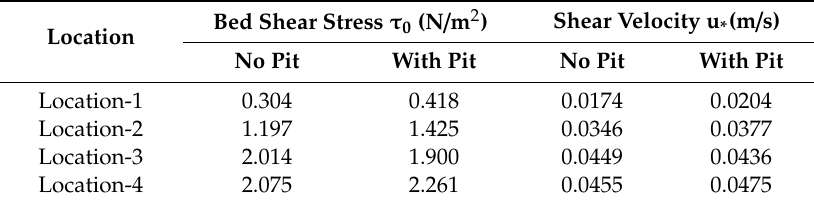
Table 1. Bed shear stress ( τ 0 ) and shear velocity ( u ∗ ) at Locations 1, 2, 3, and Location